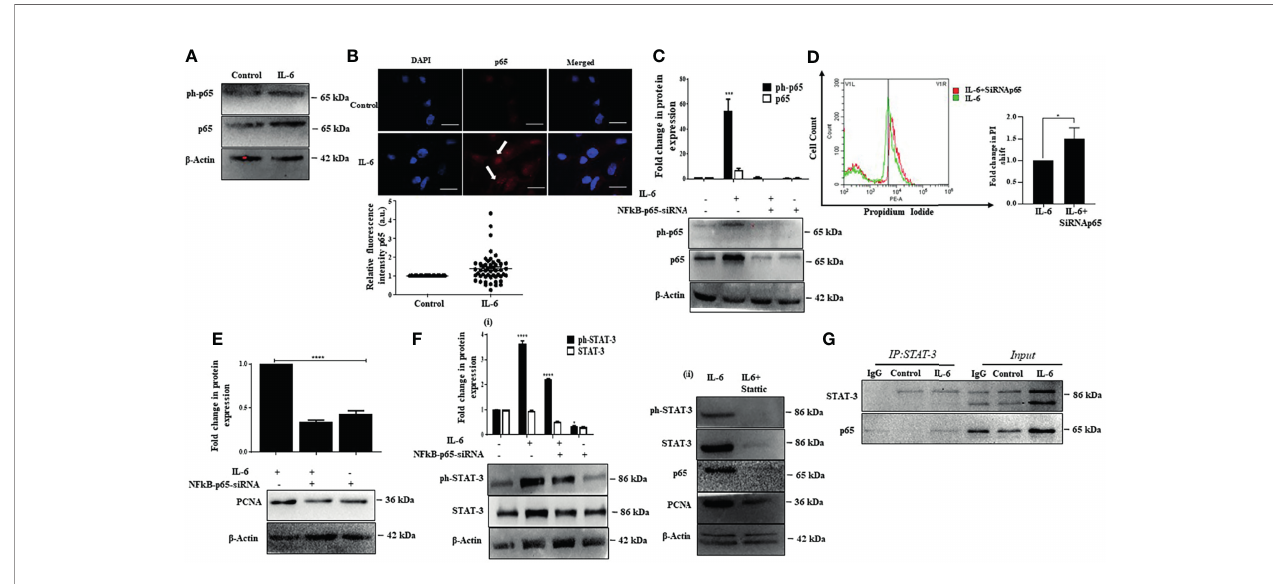
FIGURE 4 | p65 activation enhances proliferation co-operatively with STAT-3. (A) Immunoblot showing expression of p65 after IL-6 treatment for 72 h. (B) Immuno fl uorescence image and relative fl uorescence intensity of p65 in untreated and IL-6-treated cells (scale bar: 10 m m). The white arrow indicates p65. (C) Immunoblot showing expression of p65 in IL-6-treated or IL-6 plus p65-siRNA treated cells after 72 h of exposure. (D) Graph representing a shift in PI fl uorescence in IL-6-treated or IL-6 plus p65-siRNA treated cells after 72 h. (E) Immunoblot showing expression of PCNA in IL-6-treated or IL-6 plus p65-siRNA treated cells after 72 h of treatment. (F) (i) Immunoblot showing expression of STAT-3 in IL-6-treated or IL-6 plus p65-siRNA treated cells after 72 h (ii) Immunoblot showing expression of STAT-3, p65, and PCNA in IL-6-treated or IL-6 plus Stattic exposed cells. (G) Co-immunoprecipitation analysis of STAT-3 with p65 after IL-6 exposure for 72 h The proteins were immunoprecipitated with anti-STAT-3 antibody and then probed with p65. *, *** and **** refers to p value signi fi cance of ≤ 0.1, ≤ 0.001 & ≤ 0.0001